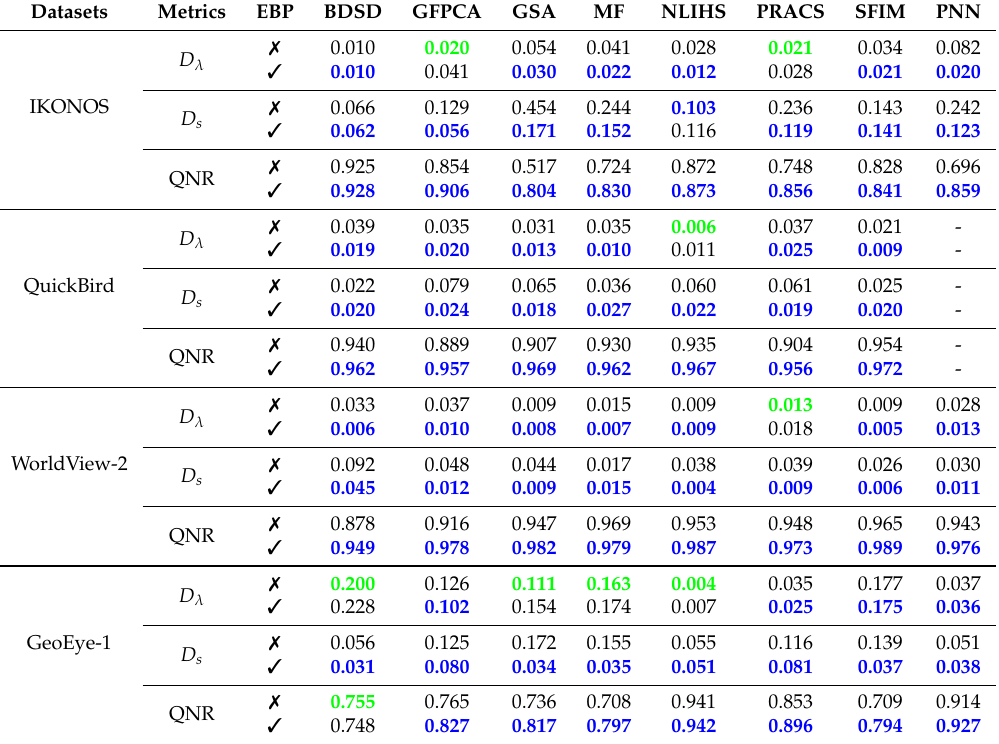
Table 2. Quantitative comparison for the eight methods without (denoted by (cid:55) ) and with (denoted by (cid:51) ) postprocessing by our proposed EBP on four kinds of satellite datasets in the full scale. Note that, for better comparison, the results improved by EBP are highlighted in blue, otherwise the original results are colored in